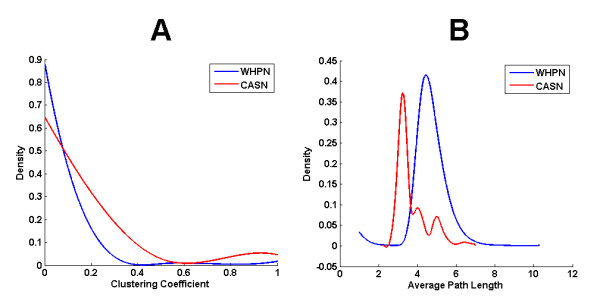
Probability density distributions of the clustering coefficient and average path length for WHPN and CASN. The blue and the red lines are for WHPN and CASN, respectively. (A) The decline for CASN is gentler than for WHPN. The x axis is the clustering coefficient with a range of 0 to 1. The probability density of the clustering coefficient is on the y axis. (B) Average path length is shown on the x axis and the probability density of average path length is on the y axis.